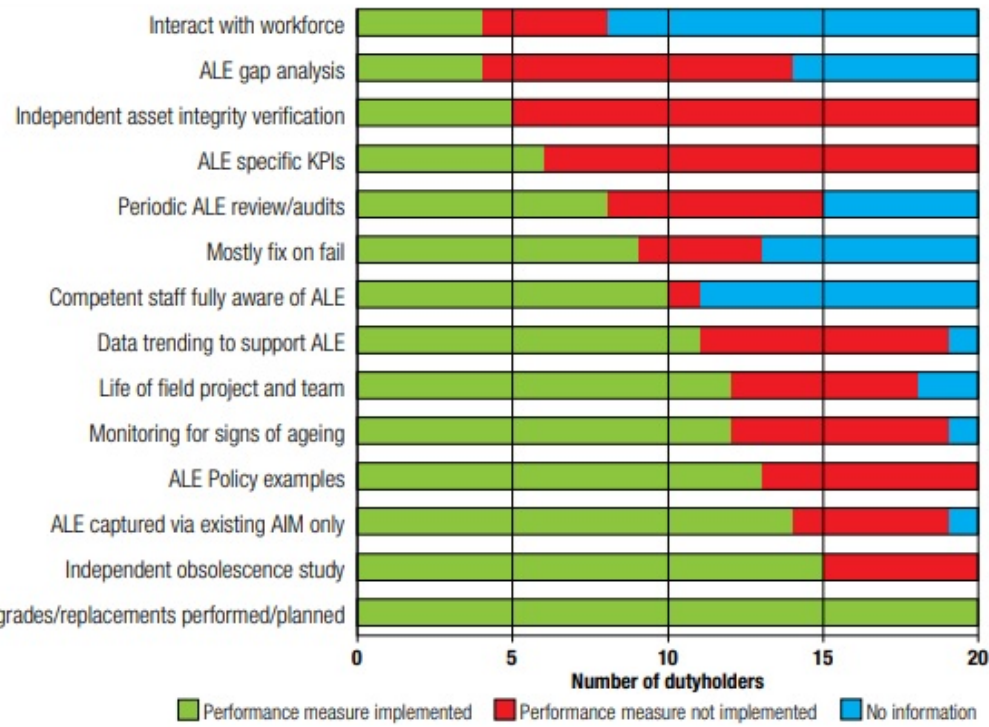
Figure 11. Typical inspection report performance factors showing good practice performance measures distilled from the electrical, control, and instrumentation inspections (this image is re- used/reproduced with permission of the Health and Safety Executive under the terms of the Open Government License, Courtesy: HSE, UK. Source: [189]).